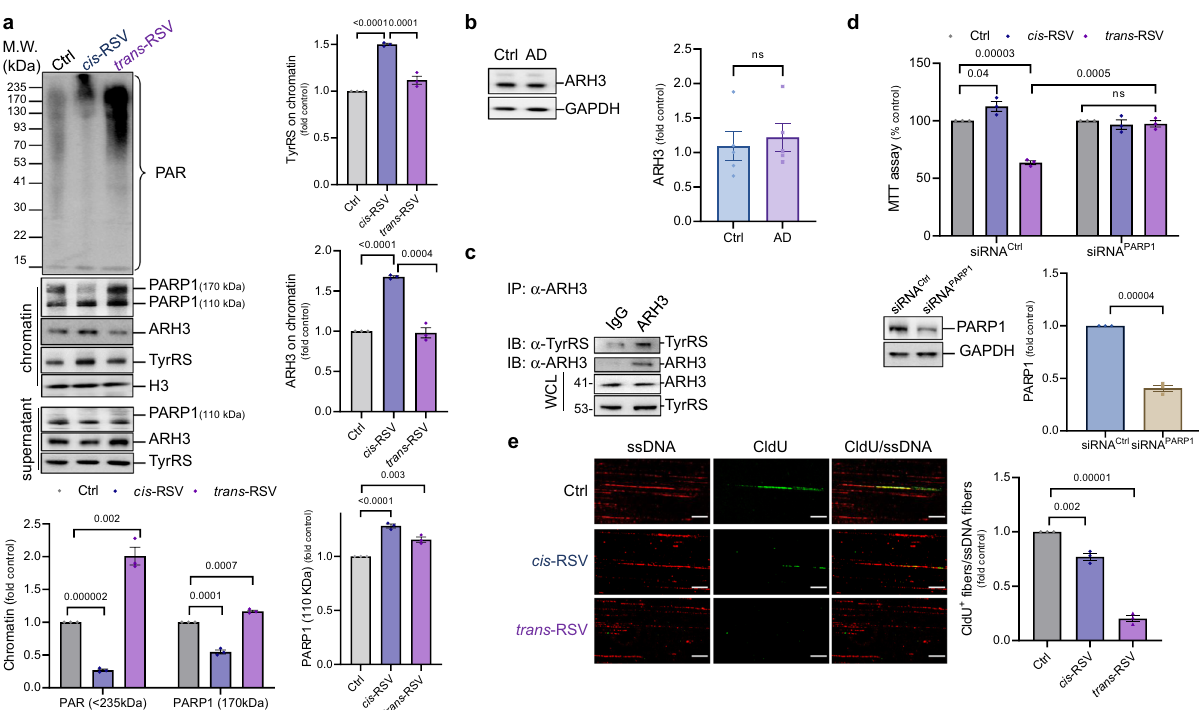
Fig. 8 Cis - and trans -RSV have opposite effects on ARH3-mediated chromatin de-ADP-ribosylation and ‘ trapped ’ -PARP1 mediates the neurotoxic effects of trans -RSV. a Cis-RSV removes auto-PARylated PARP1 from chromatin and trans-RSV ‘ traps ’ PARP1 onto the chromatin . Representative immunoblots and quanti fi cation from chromatin fraction of cortical neurons (DIV 9) depicting PARP1 and PAR, ARH3, TyrRS after treatment with cis - and trans -RSV (50 µ M) for 1 hr. b ARH3 levels are not affected in the hippocampal tissues of AD patients . Representative immunoblots and quanti fi cation for ARH3 using anti- ARH3 antibody in the hippocampal region of AD patients ( n = 5) with age and sex-matched controls ( n = 5). c TyrRS interacts with ARH3 . Immunoprecipitated (IP) ARH3 from cortical neurons (DIV 9) was immunoblotted (IB) using anti-TyrRS and anti-ARH3 antibodies to detect the interaction of TyrRS with ARH3. Total TyrRS and ARH3 were detected by WB in the whole cell lysate (WCL). d siRNA knockdown of PARP1 rescues trans-RSV-mediated neurotoxicity . Rat cortical neurons (DIV 7) were transfected with siRNA against PARP1 (siRNA PARP1 ) or control siRNA (75 nM) and then treated with cis - RSV (50 µ M) or trans -RSV (50 µ M) for 72 hr. Neuronal viability was assessed and quanti fi ed using an MTT assay. The knockdown was veri fi ed using immunoblot and quanti fi ed using speci fi c antibodies for PARP1. e trans-RSV inhibits nucleoside incorporation in a DNA fi ber assay . Cortical neurons (DIV 9/10) were treated with cis -or trans -RSV (50 μ M) for 8 hr followed by a 30 min pulse labeling using 50 µ M of nucleoside analog, CldU (5-chloro-2 ′ - deoxyuridine). DNA fi ber assay was performed according to the published protocol followed by immunostaining for single-stranded (ss) DNA (red) and CldU (green). Representative images (scale bar, 100 µ m) showing the incorporation of CldU into DNA during the repair process was assessed using ImageJ by counting the number of CldU positive DNA fi bers for a total of 300 fi bers per condition. All data represent mean ± SEM with statistical signi fi cance calculated using two-tailed Student ’ s unpaired